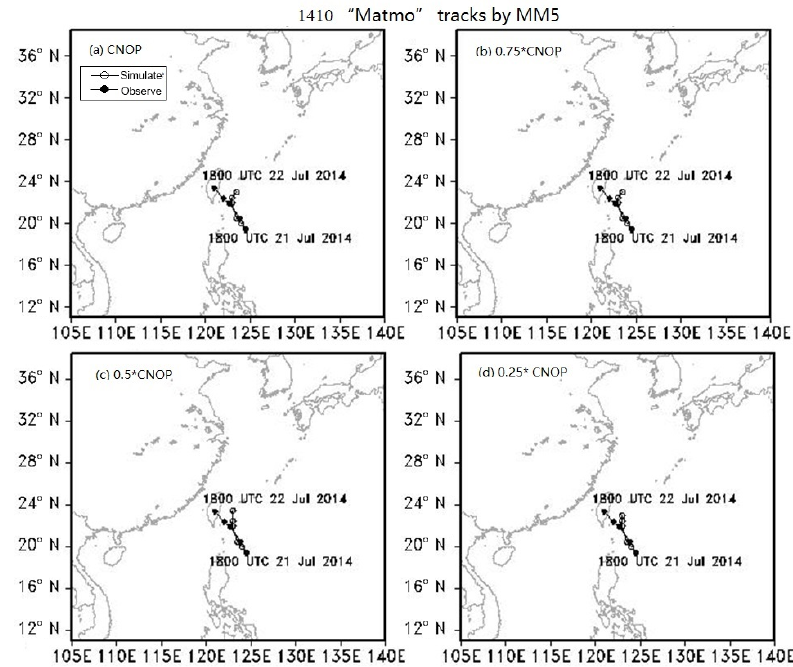
Figure 16. Simulated TC tracks from MM5 through the insertion of the CNOPs or W × CNOP into the initial state in the entire domain for TC